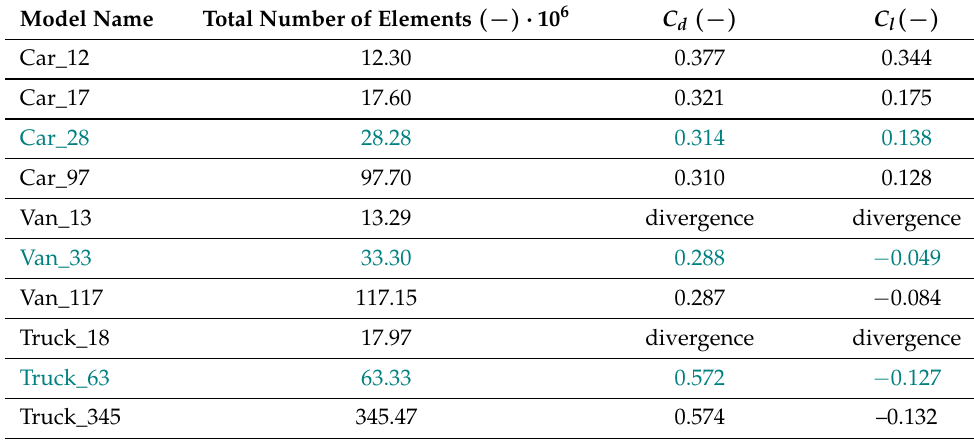
Table 2. Influence of mesh density on aerodynamic